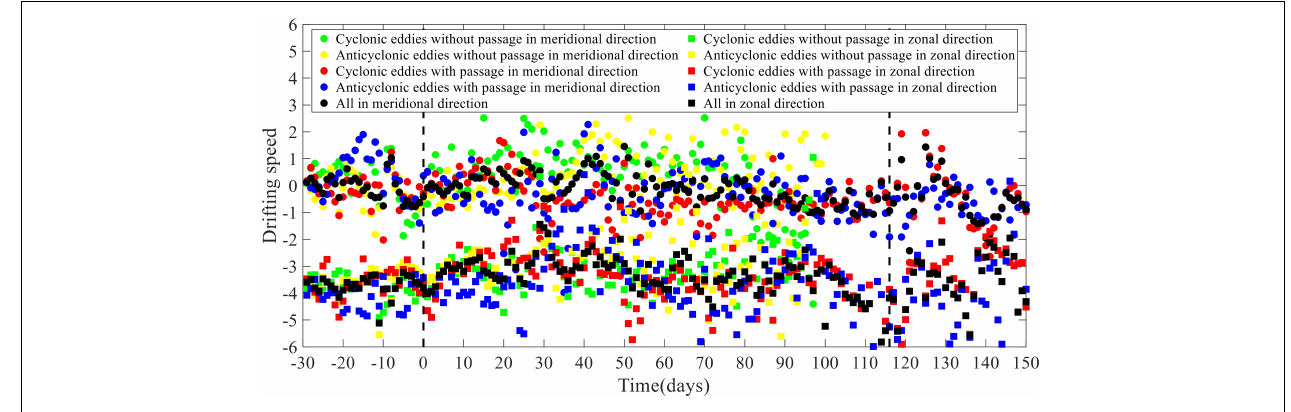
FIGURE 6 | Distribution of zonal and meridional drifting